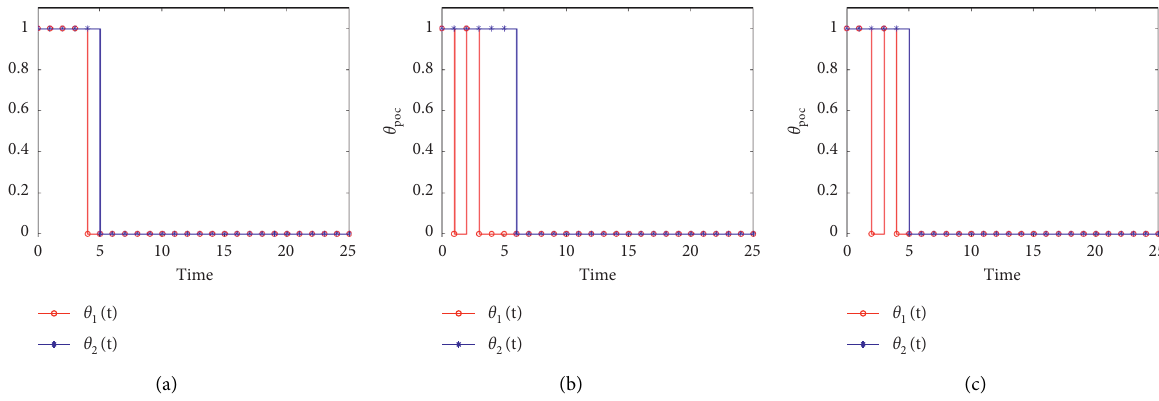
Figure 5: Optimal control strategies θ in networks: (a) Facebook network, (b) e-mail network, and (c) Twitter poc